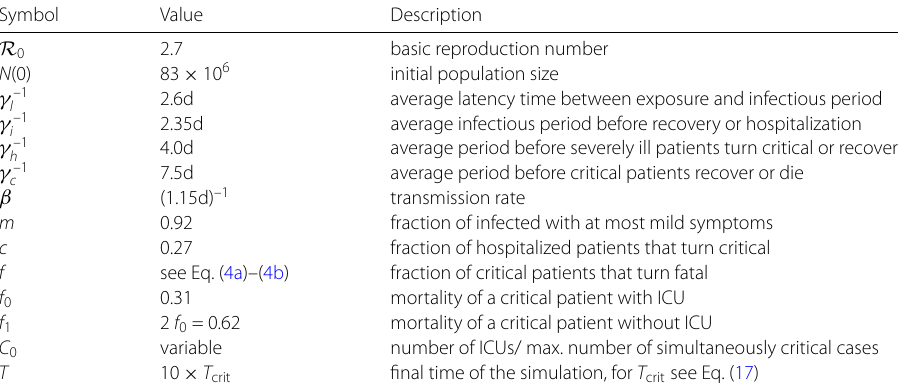
fraction of critical patients that turn fatal f 0.31 mortality of a critical patient with ICU f mortality of a critical patient without ICU C 0 variable number of ICUs/ max. number of simultaneously critical cases